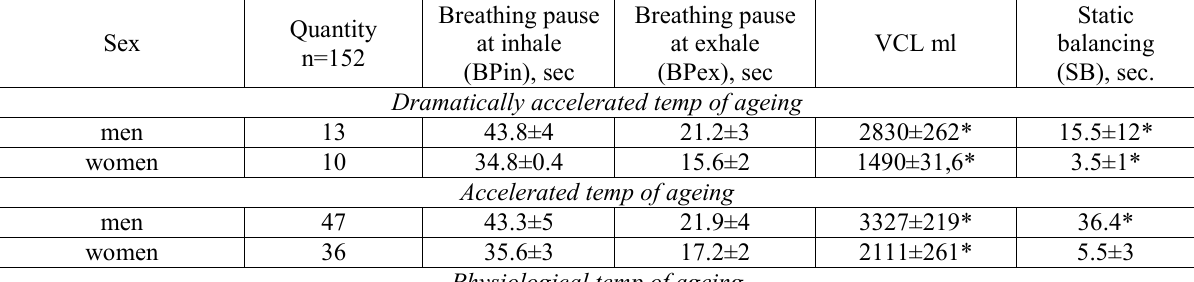
Parameters of respiratory system’s functional potentials and static balancing of 50-60 years old persons with different temp of